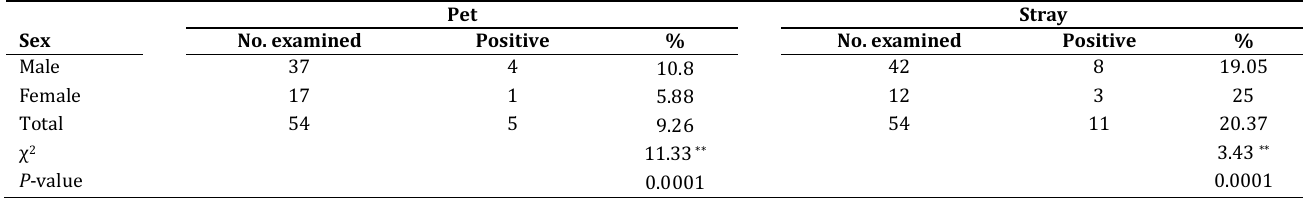
Table 3 . Dipylidium caninum infection rates in pet and stray dogs according to the sex Pet